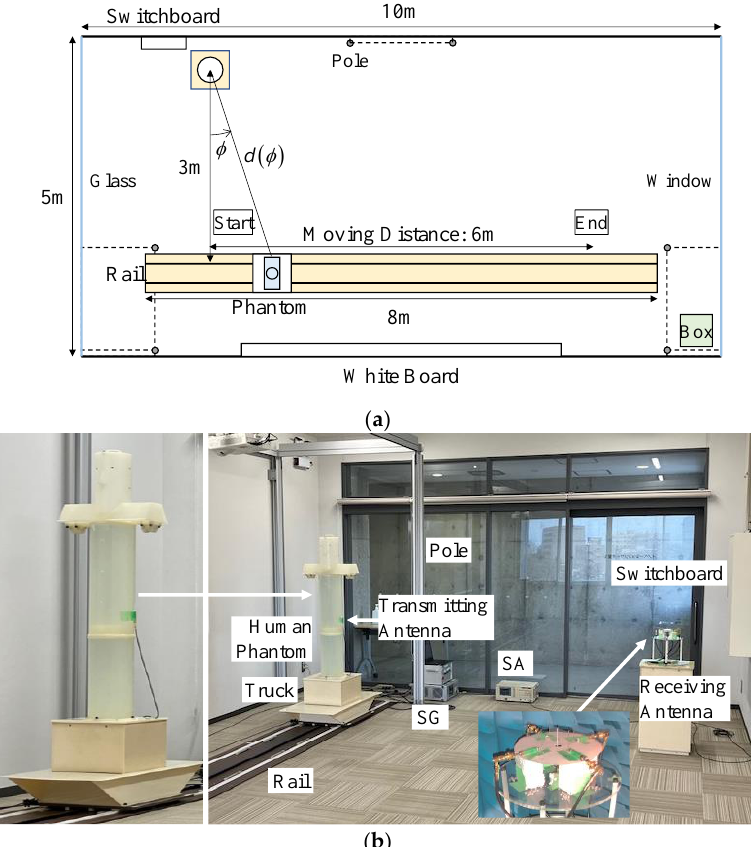
Figure 23. Radio propagation experiment performed in an indoor situation: ( a ) top view of the indoor measurement environment and ( b ) measurement setup in the classroom.